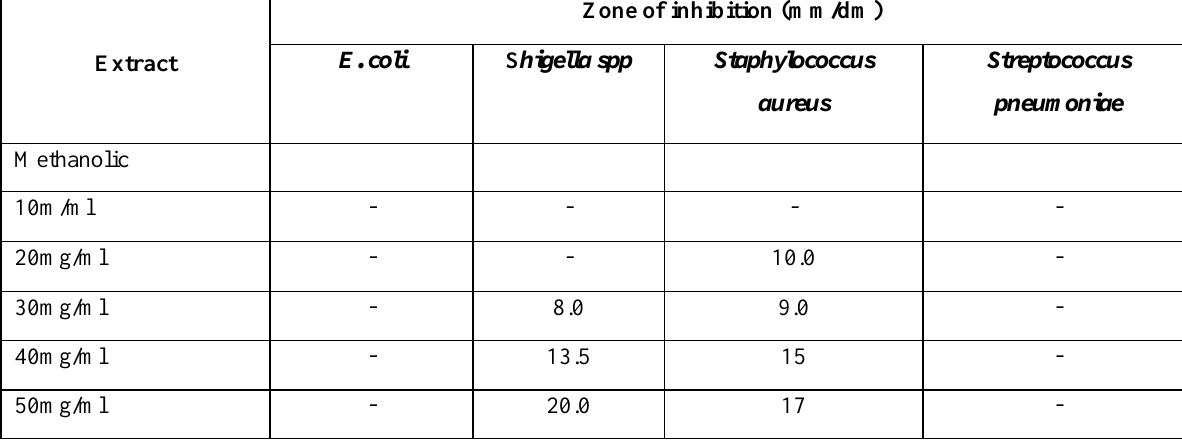
Table 4. Zone of inhibition of methanolic extract of Moringa oleifera against the organisms.